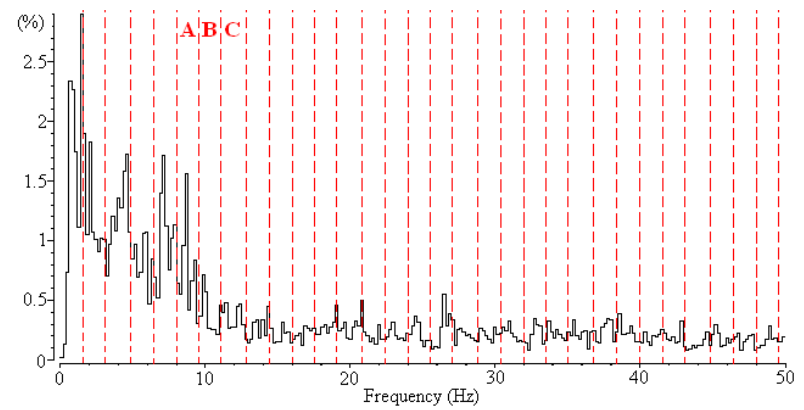
Figure 2. EEG spectrum obtained by applying fast Fourier transform (FFT) and dividing its resolution into 32 frequency bands.